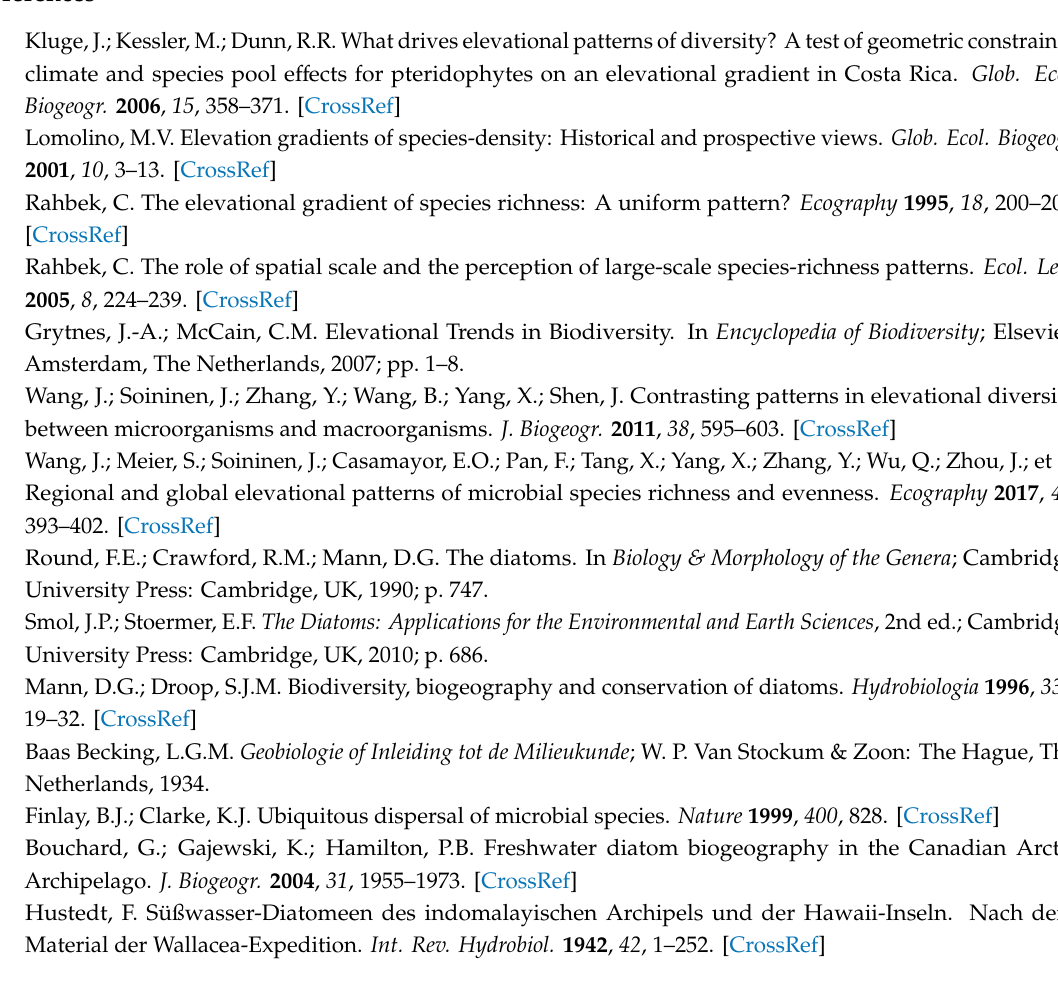
Table S1: Range of environmental factors of the sampled springs; Table S2: Description of the sampled